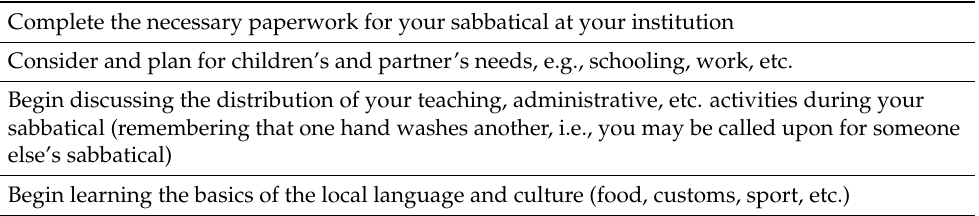
Table 2. 1–2 years before your sabbatical.